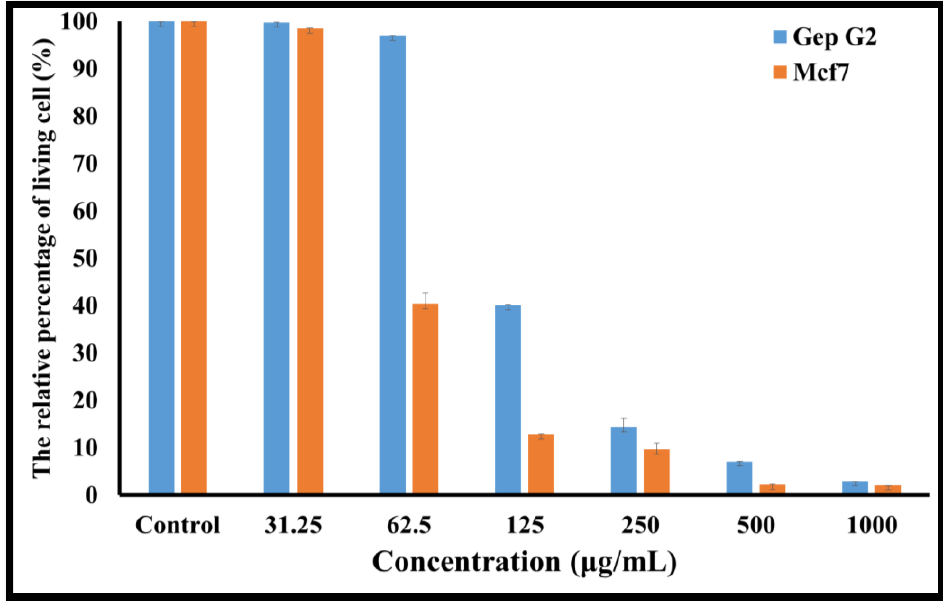
Figure 8. Relative percentages of living cells of Hep G2 and Mcf7 cancer cells after exposure to different concentrations of Co 3 O 4 NPs synthesized using rosemary leaf extract. The results are from an MTT assay and are displayed as the mean ± SD (n = 3).